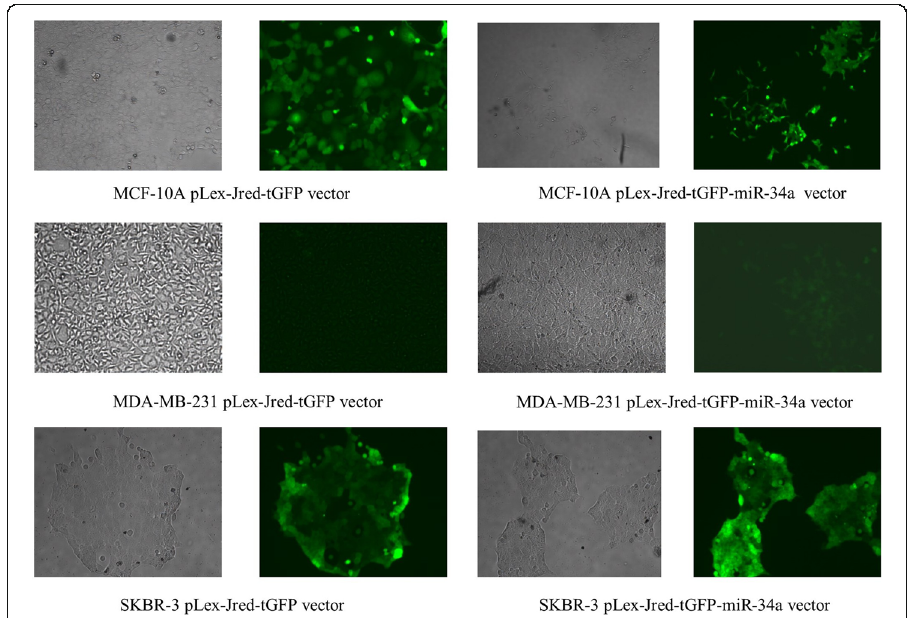
Fig. 3 Light and fluorescent microscopy picture of MCF-10A, MDA-MB-231, and SK-BR-3 cells transduced with viruses containing control vector or